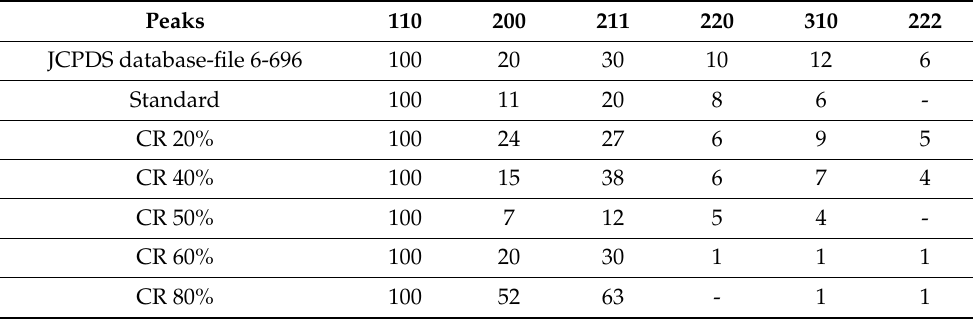
Figure 3. XRD patterns of standard EUROFER97 steel and after cold rolling with increasing CR ratio. Table 2. Relative intensities of XRD peaks of EUROFER97 steel prepared according to the standard treatment and after cold rolling with increasing CR ratio. The values have been determined from patterns in Figure 3. Data from the file 6–696 of JCPDS database [59] referring to Fe with randomly oriented grains are reported for comparison.